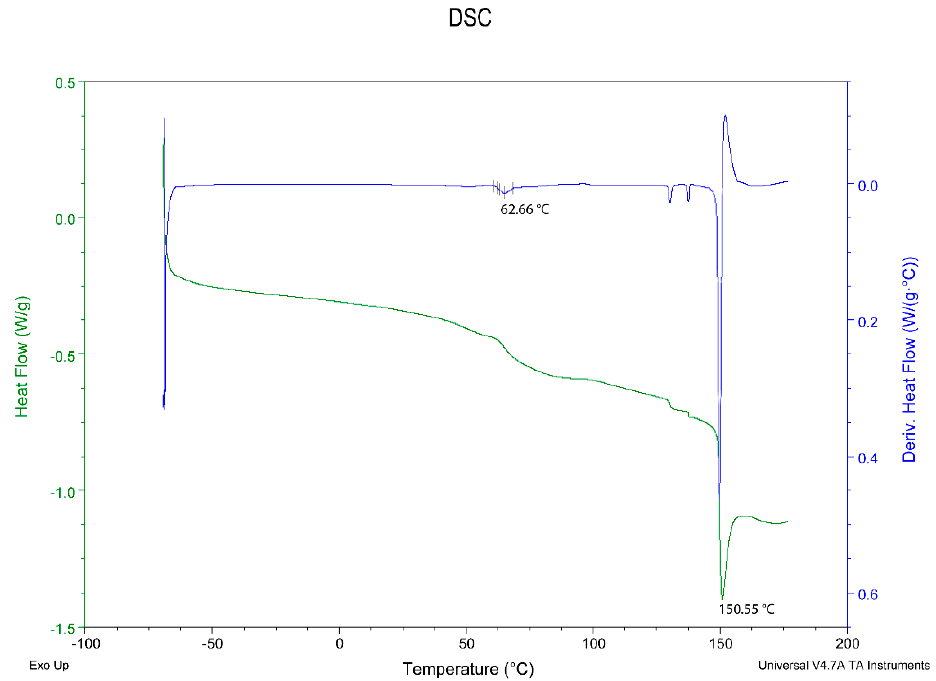
Figure 6. DSC of purified WTPS.